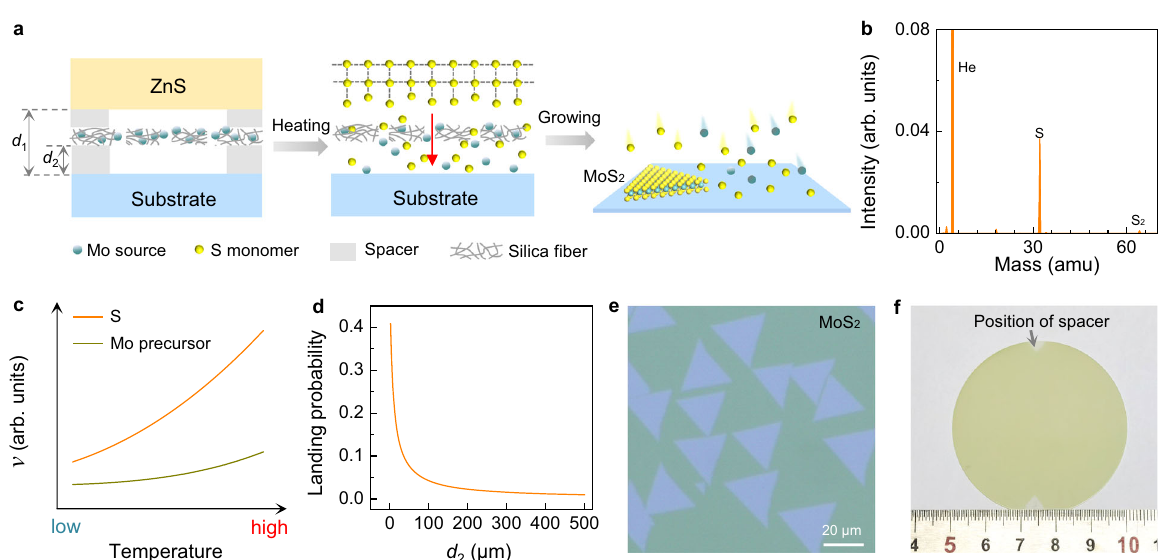
Fig. 1 Growth of wafer-scale monolayer MoS 2 by sulfur monomer supply. a Schematic of sulfur (S) monomer supply for the growth of MoS 2 . At high temperature, the released S monomers from the surface of ZnS and the vaporized Mo source from the precoated silica fi ber fabric can penetrate the porous fabric and form monolayer MoS 2 on the target substrate. d 1 and d 2 are the distances from the substrate to the ZnS and the silica fi ber fabric, respectively. The red arrow denotes the diffusion of S monomers released from the ZnS surface. b In-situ mass spectrum of ZnS annealed at 1000 °C. The intense peak at the mass of 32 clearly proves the dominating release of S monomers. The measurements were carried out with carrier gas of He and the data was subtracted by background. c The illustration of the temperature-dependent release rate of S monomers (orange curve) and evapouration rate of Mo precursor (dark yellow curve). d The landing probability of Mo precursor (orange curve) as a function of d 2 as modelled in Supplementary Note 2. e Optical image of the as-grown monolayer MoS 2 domains on sapphire when d 2 is 100 μ m. f Photograph of a 2-inch monolayer MoS 2 fi lm on sapphire when d 2 is 20 μ m. The uncovered regions are the positions of the mica